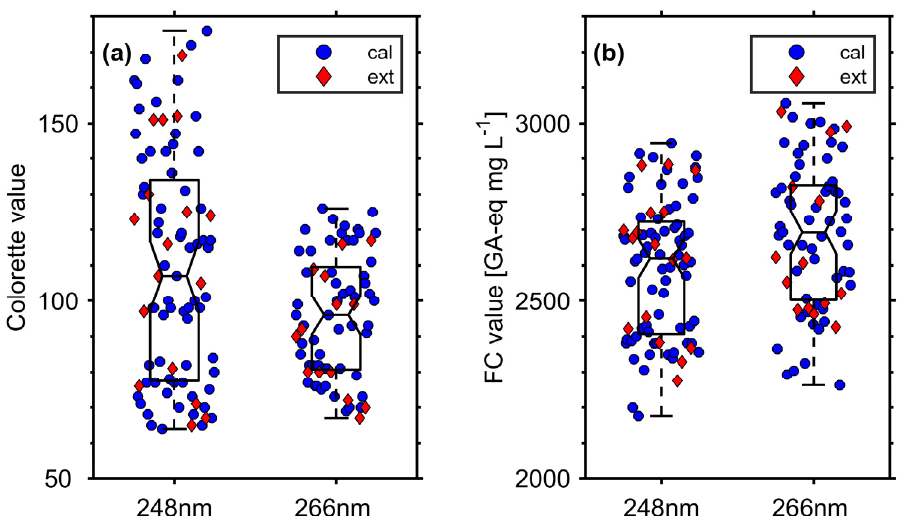
Figure 3. ( a ) Colorette and ( b ) FC values of single roast, divided by REMPI wavelength and their belonging to either the calibration (cal, blue circles) or test dataset (ext, red diamonds). The boxes show the 1st, 2nd (median), and 3rd quartile of the entire data set, while whiskers illustrate the full range (minimum and maximum) of the measurements. Since the notches of boxes in each subfigure do not overlap, the medians of the distribution from measurements at 248 nm and 266 nm are not significantly different at a confidence level of 95%.